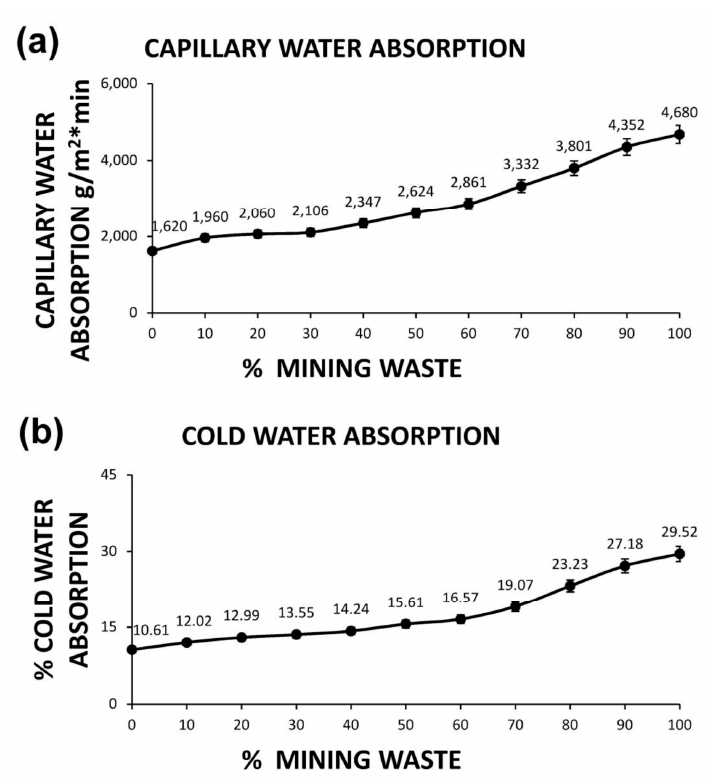
Figure 3. Physical properties of ceramic families with clay and mining residue after sintering ( a ) capillary water absorption and ( b ) cold water absorption.